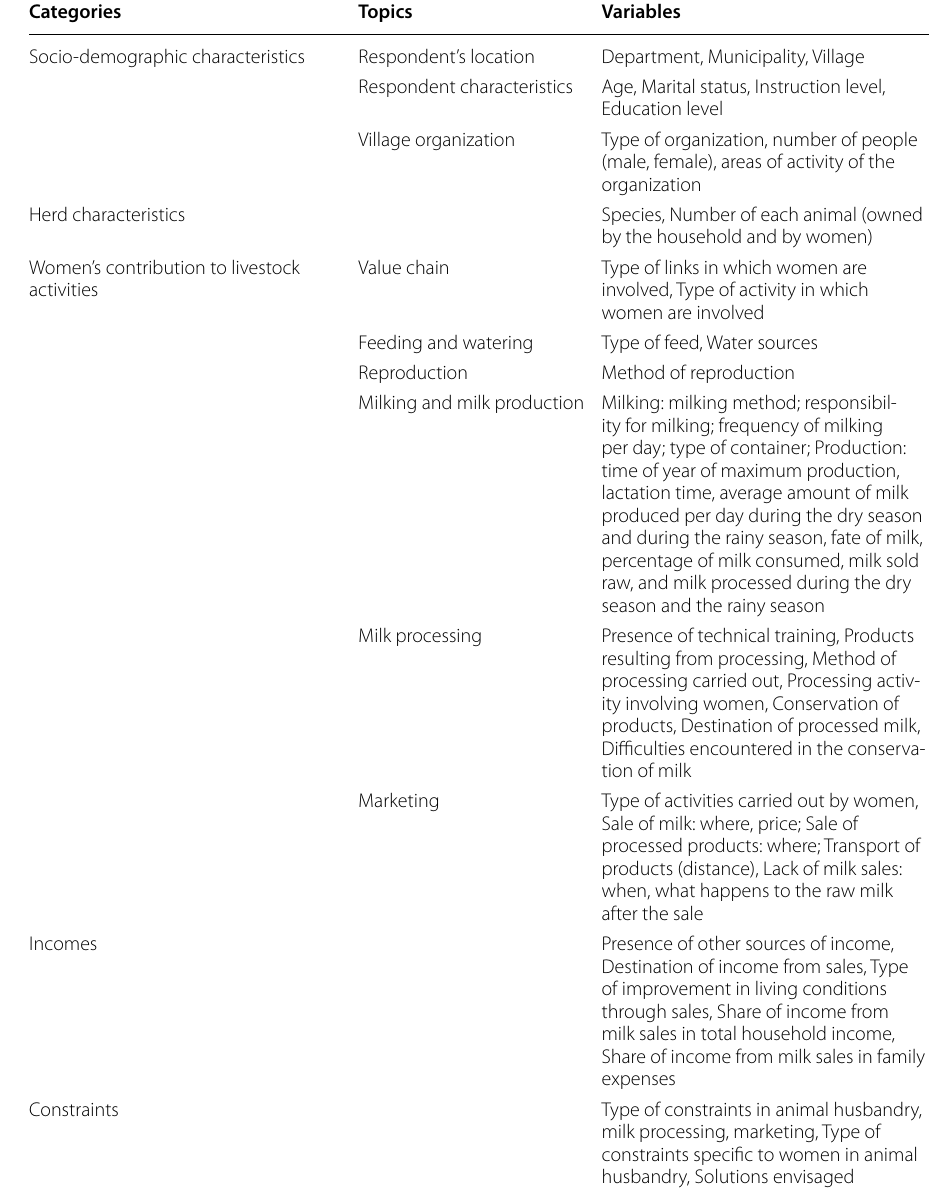
Table 1 Target categories and topics of the survey questionnaires and variables used for